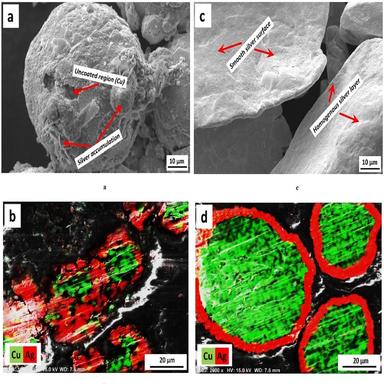
SEM images of (a) s-CuAg, (b) cross-section region of s-CuAg, (c) f-CuAg and (d) cross-section region of f-CuAg.